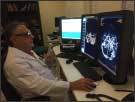
Dr. Jacques Widelec